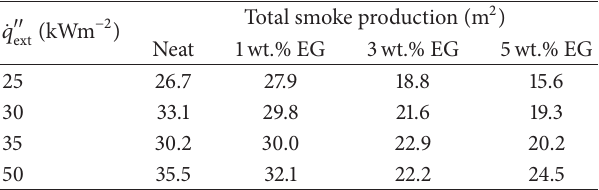
Table 6: The total smoke production for the samples.